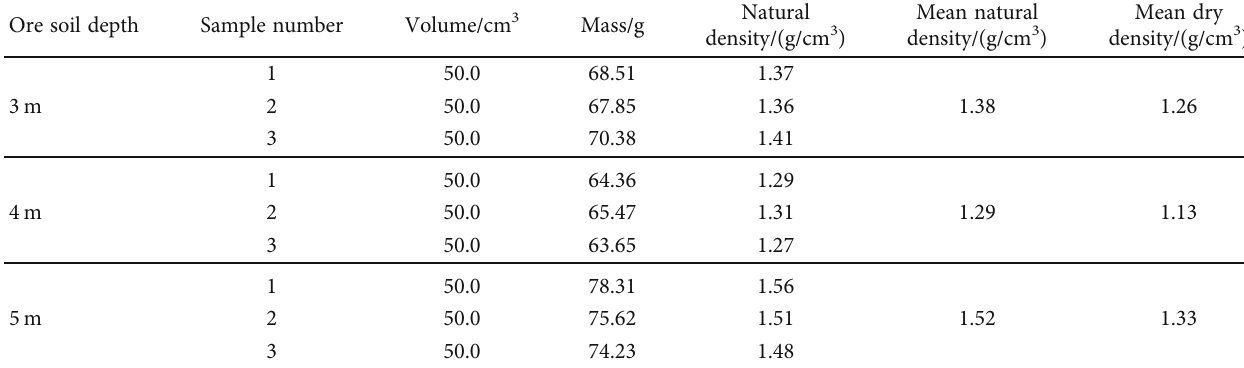
Table 1: Density of ore samples.